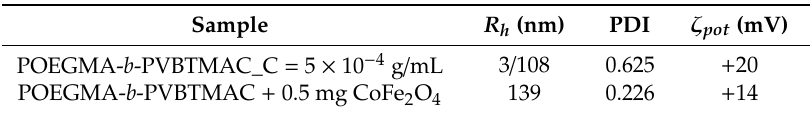
Figure 1. Size distribution from Contin for the POEGMA- b -PVBTMAC diblock at 90° in aqueous solutions (solvent: water for injection). Table 2. DLS and ELS results for the POEGMA- b -PVBTMAC copolymer and POEGMA- b -PVBTMAC + 0.5 mg CoFe 2 O 4 complexes in aqueous solutions.